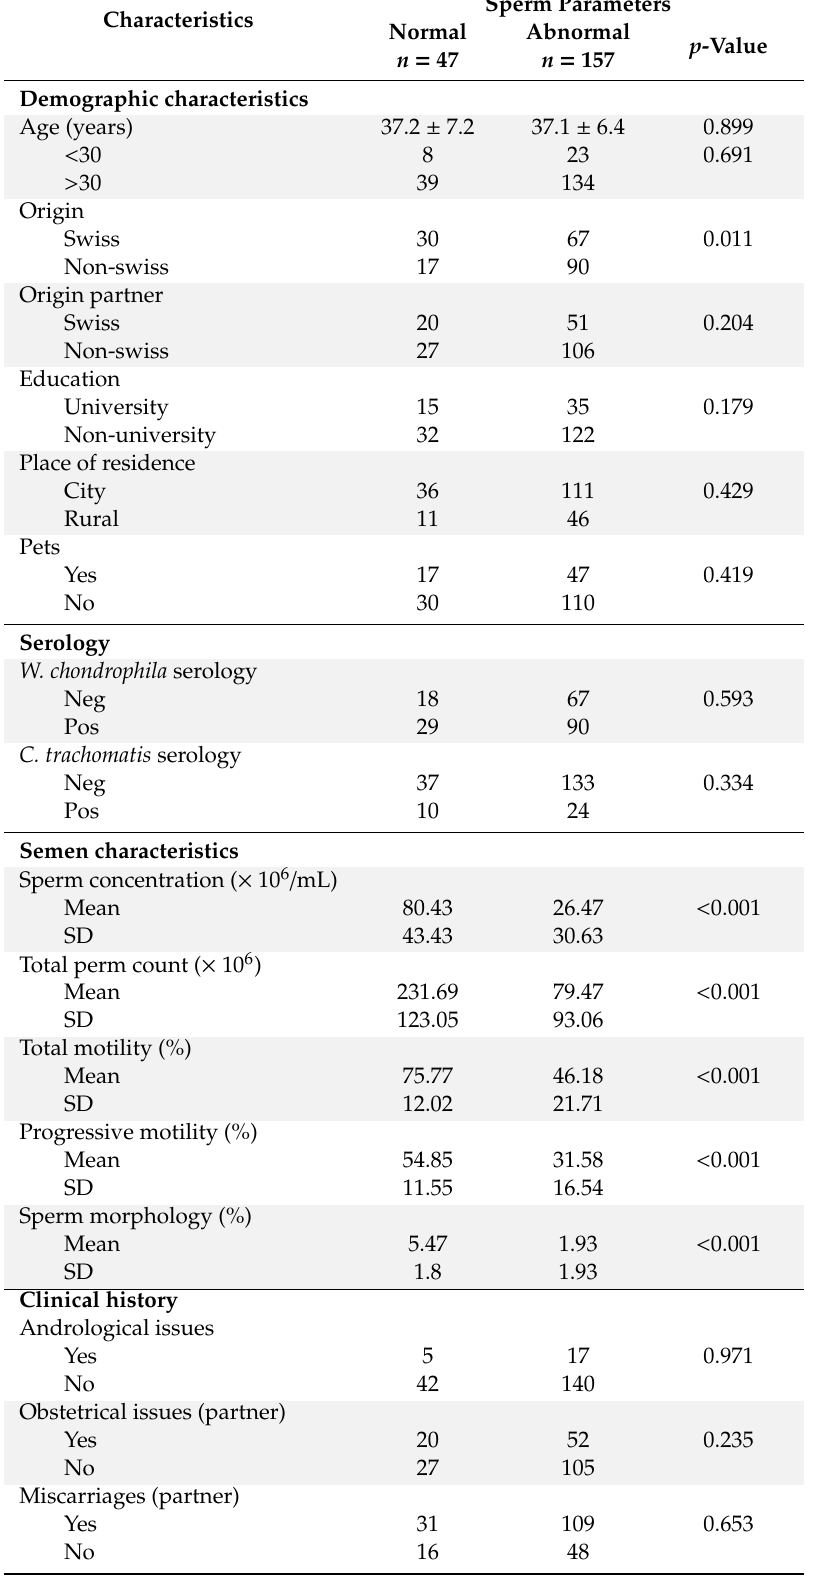
Table 3. Characteristics of patients according to semen parameters.